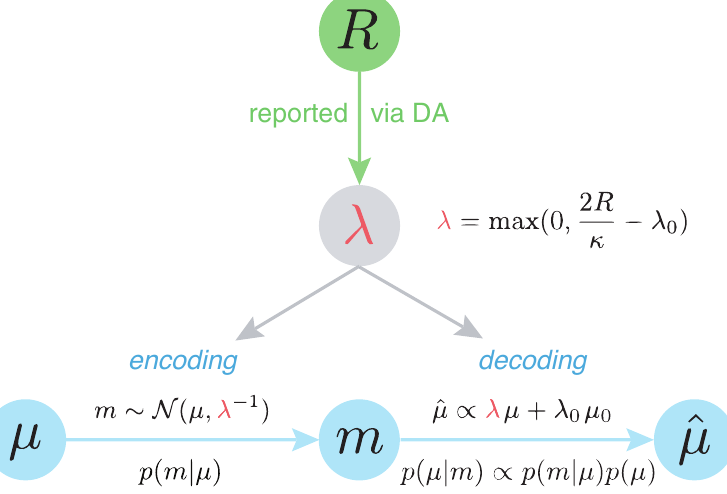
Fig 2. Rational inattention model of DA. Under rational inattention, average reward controls the likelihood precision through tonic DA. As derived in the next section and summarized in the top equation, increases in average reward increase likelihood precision, which in turn affects both encoding and decoding. Because average reward is a property of the context, DA can relay the likelihood precision (i.e., the precision of encoding) to the decoding stage, even when encoding and decoding are temporally decoupled. R : reward; κ : unit cost of attention (or information; see next section); λ : likelihood precision; λ 0 : prior precision; μ : likelihood mean (objective values); m : subjective (stored) values; μ 0 : prior mean; ^ m : posterior mean (estimate of μ ); p ( m | μ ): likelihood; p ( μ ): prior; p ( μ | m ):